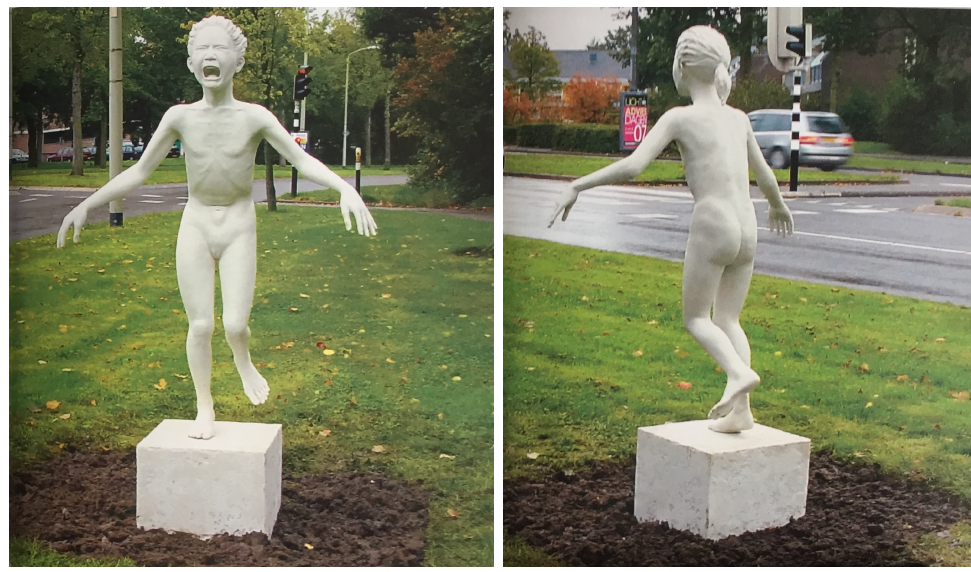
Figure 1: Anno Dijkstra: Kim Phuc , Hoorn, 2007/08. © Anno